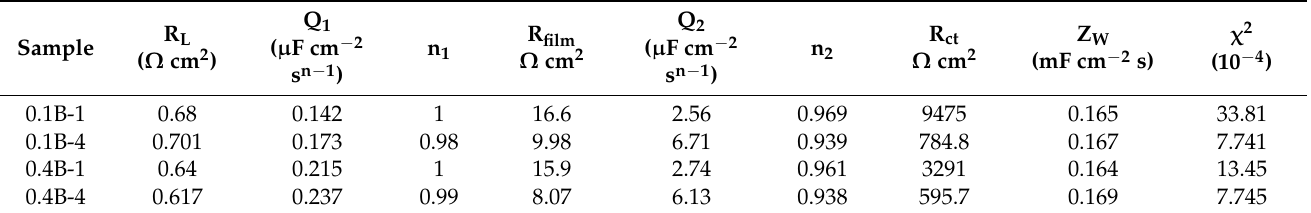
Figure 4. ( a , b ) Impedance spectra of different BDD electrodes in 1mM K 3 [Fe(CN) 6 ] with 0.1 M KCl electrolyte, ( c , e ) Enlarged impedance spectra of the BDD electrodes with 0.1 B 2 H 6 and 0.4 B 2 H 6 doping, respectively. ( d ) the Equivalent circuit. Table 1. Electrochemical parameters obtained based on EIS tests on different electrodes in a mixed solution of 1mM K 3 [Fe(CN) 6 ] and 0.1M